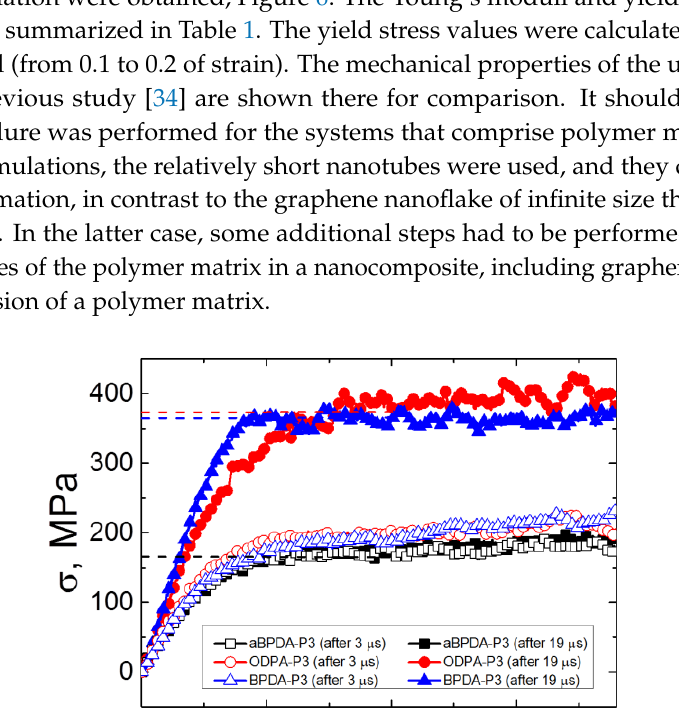
Table 1. The Young’s moduli and yield stress values for the simulated PIs aBPDA-P3, ODPA-P3, and BPDA-P3 after 3 and 19 μs of simulations (before and after the structural transition to the unfolded states). The results for the unfilled samples (without SWCNT) were calculated using the samples obtained in our previous study [34]. PI